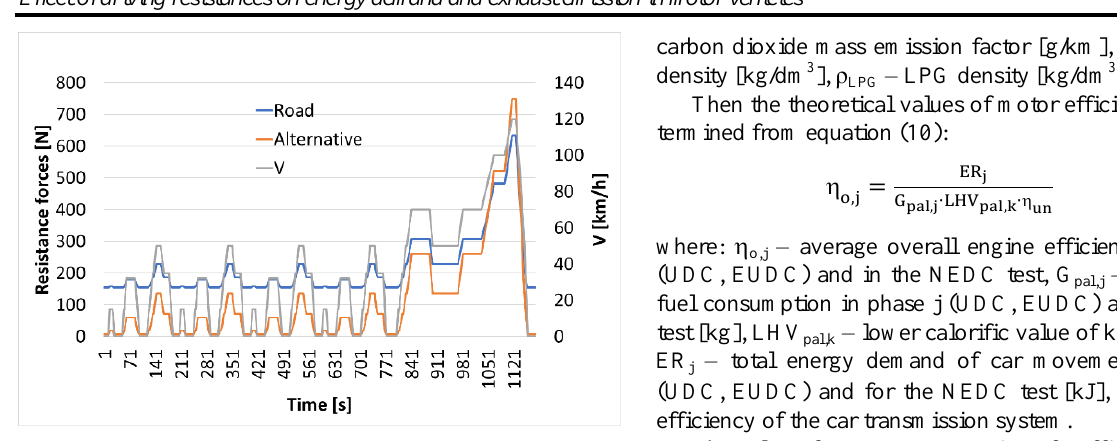
Fig. 2. Calculated resistance forces F t,p and F c for road and alternative methods